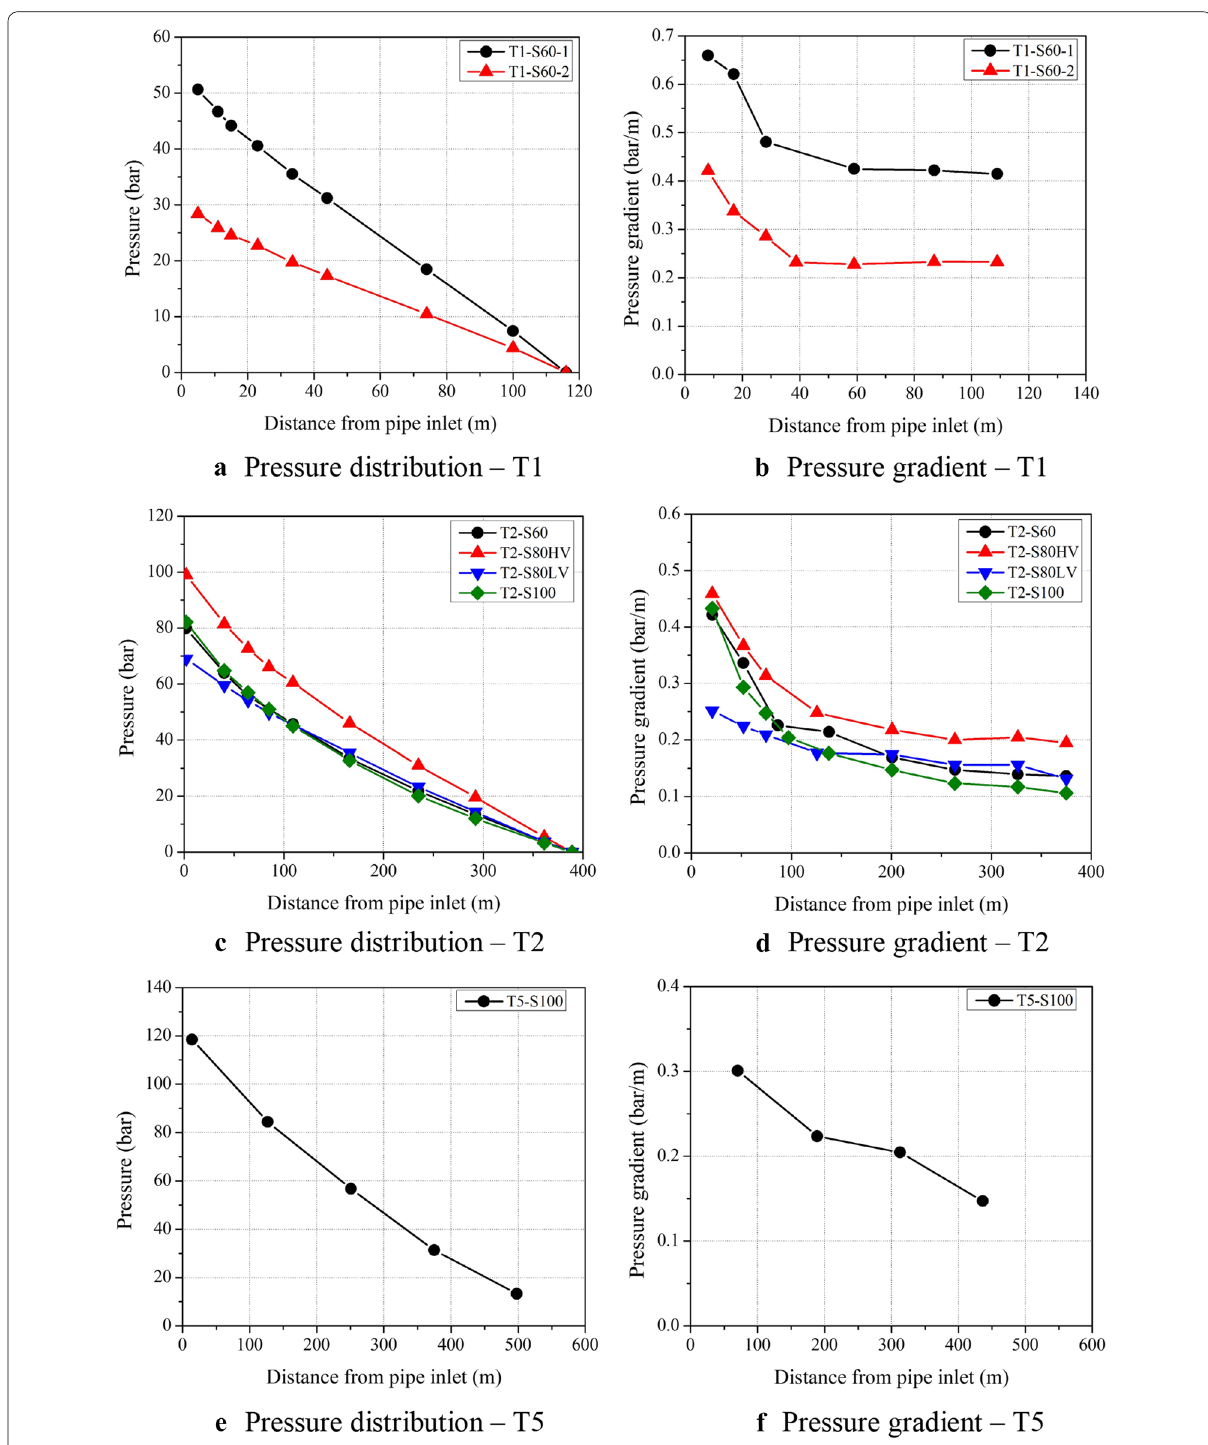
Fig. 8 Results of pressure and pressure gradient over the pipe length—decrease